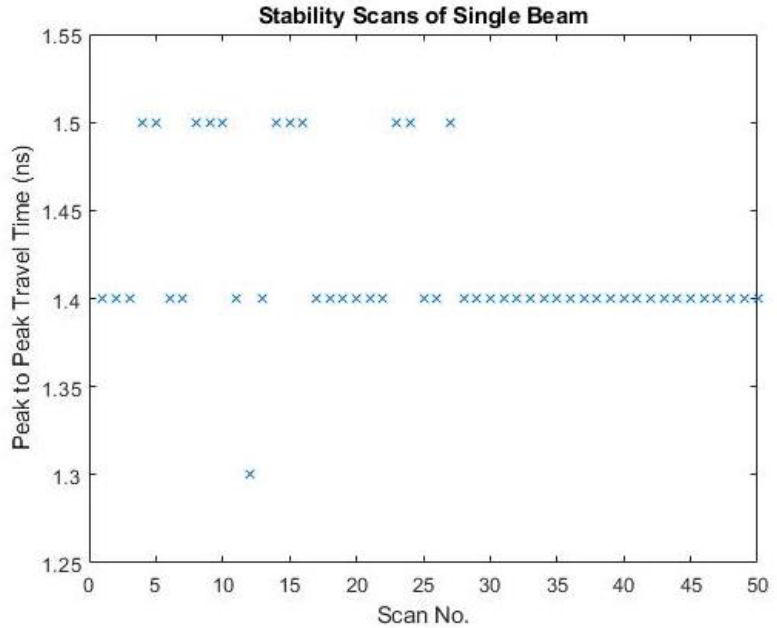
Figure 5. Plot of travel times to rebar in 50 scans of a single concrete beam. Note the resolution of 0.1 ns in the